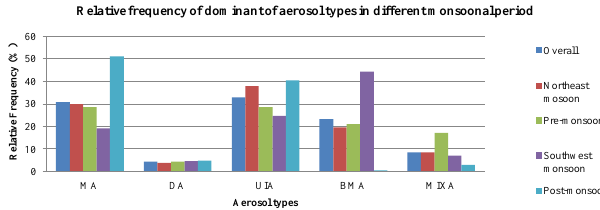
Figure 3. Seasonal classification of aerosol types based on AOD– Ångström 440 − 870 scatter plots by the threshold proposed by Toledano et al.